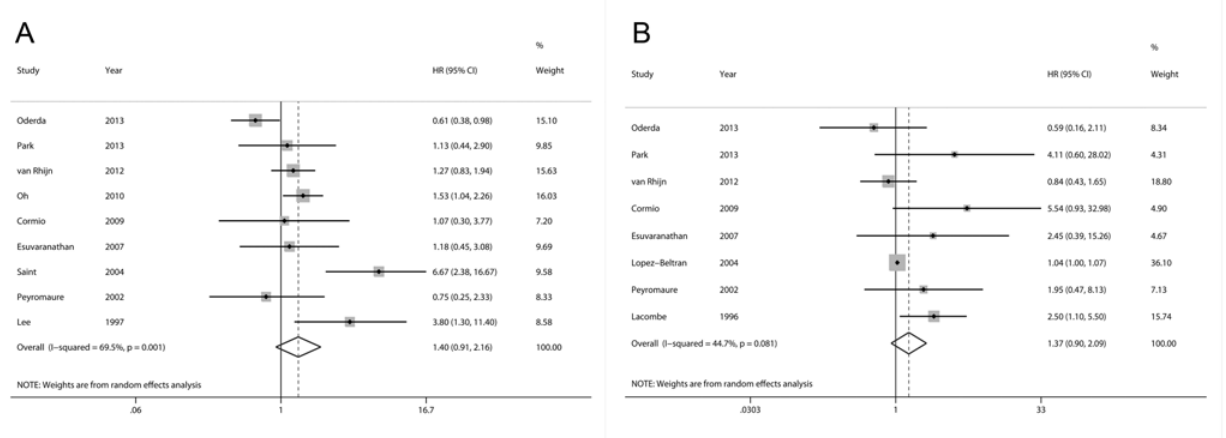
Fig 2. Forest plots of HRs estimated for the relationship between p53 expression and RFS (A) or PFS (B) among NMIBC patients treated with BCG.